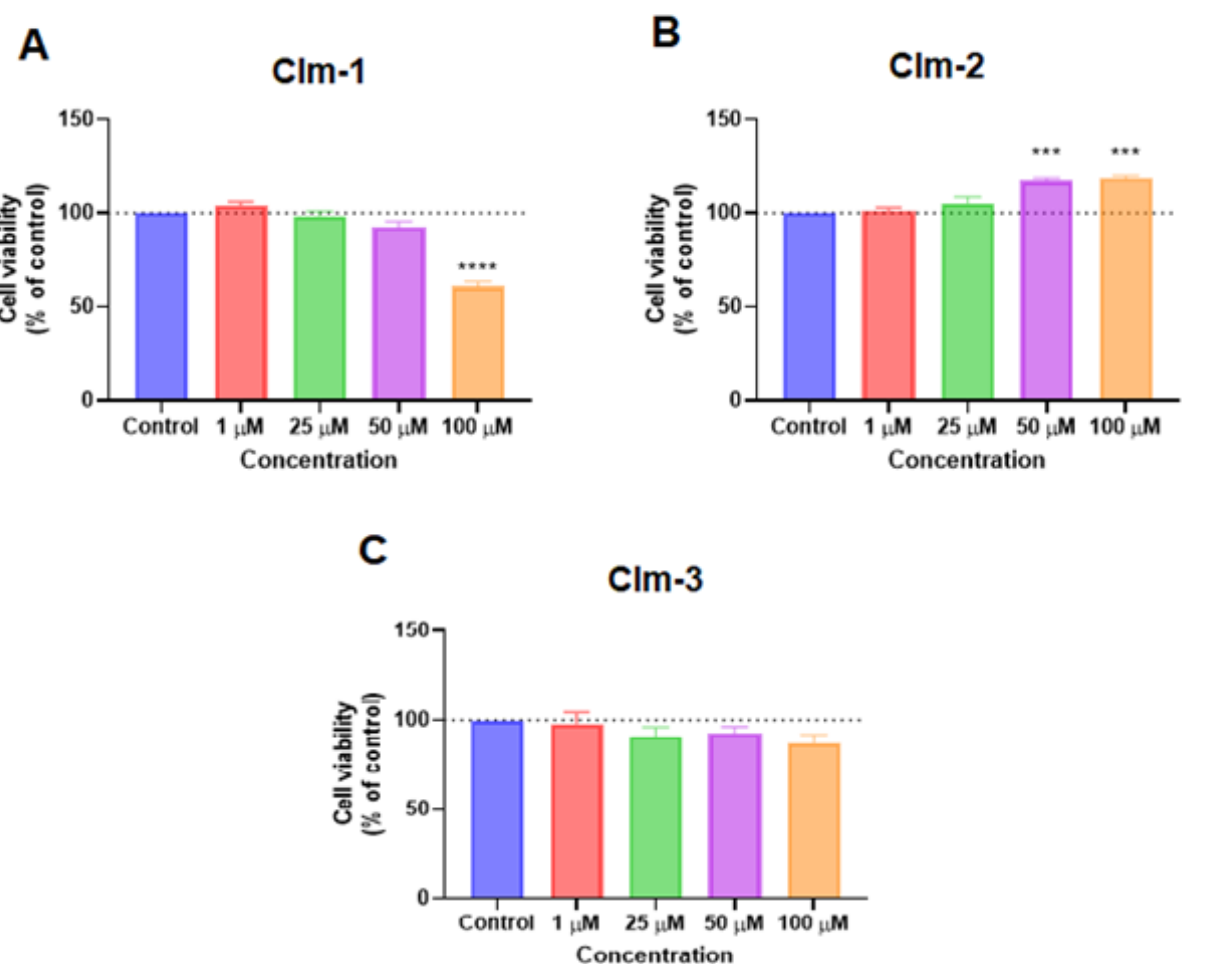
Figure 5. Biosafety evaluation of compounds ( A ) Clm-1 , ( B ) Clm-2, and ( C ) Clm-3 in MRC-5 cells. MRC-5 were treated with vehicle (methanol) and increasing concentrations (0–100 µM) of each compound for 48 h and cell viability was assessed by MTT assay. Data are given as the mean ± SEM ( n = 3), *** statistically significant vs. control (vehicle) at p < 0.001; **** statistically significant vs. control (vehicle) at p < 0.0001.